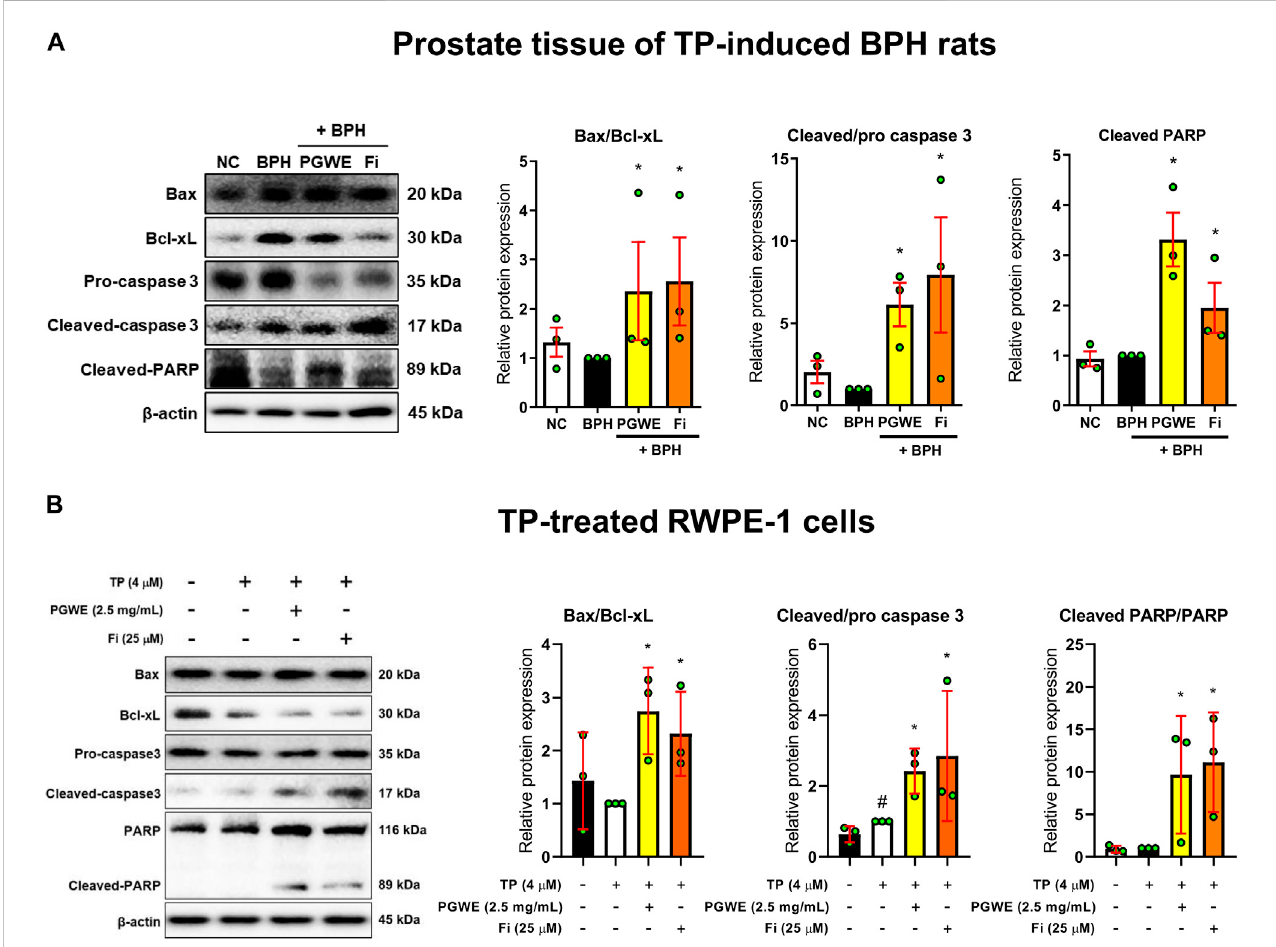
FIGURE 5 PGWE induces apoptosis in prostate tissue of BPH rats and TP-treated RWPE-1 cells (A) The expressions of Bax, Bcl-xL, caspase-3, and PARP in prostate tissueofTP-inducedBPHratswereanalyzedusingWesternblotting (B) TheexpressionsofBax,Bcl-xL,caspase-3,andPARPinTP-treatedRWPE-1cellswere analyzed using Western blotting and β -actin was used as the loading control. All data are expressed as mean ± SEM of independent experiments. Statistical differences were evaluated using an unpaired t -test and a subsequent post-hoc one-tailed Mann-Whitney U test. # p < 0.05 vs. NC groups or D.W.- treated RWPE-1 cells; p p < 0.05 vs. BPH group or TP-treated RWPE-1 cells. NC, normal control; BPH, benign prostatic hyperplasia; TP, testosterone propionate; PGWE, Panax ginseng C. A. Meyer water extract; Fi, fi nasteride; D. W., distilled